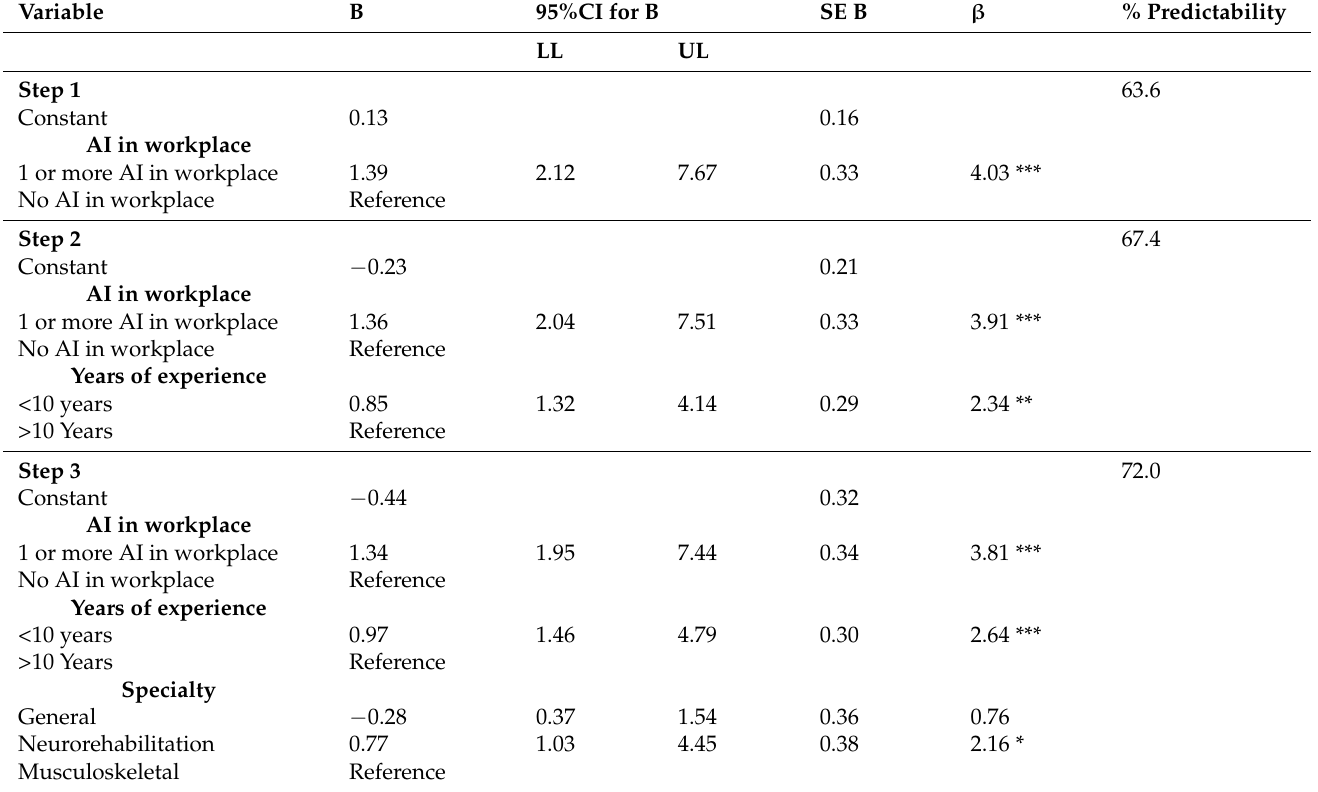
Table 3. Association between different factors influencing the knowledge of PTs on AI use in